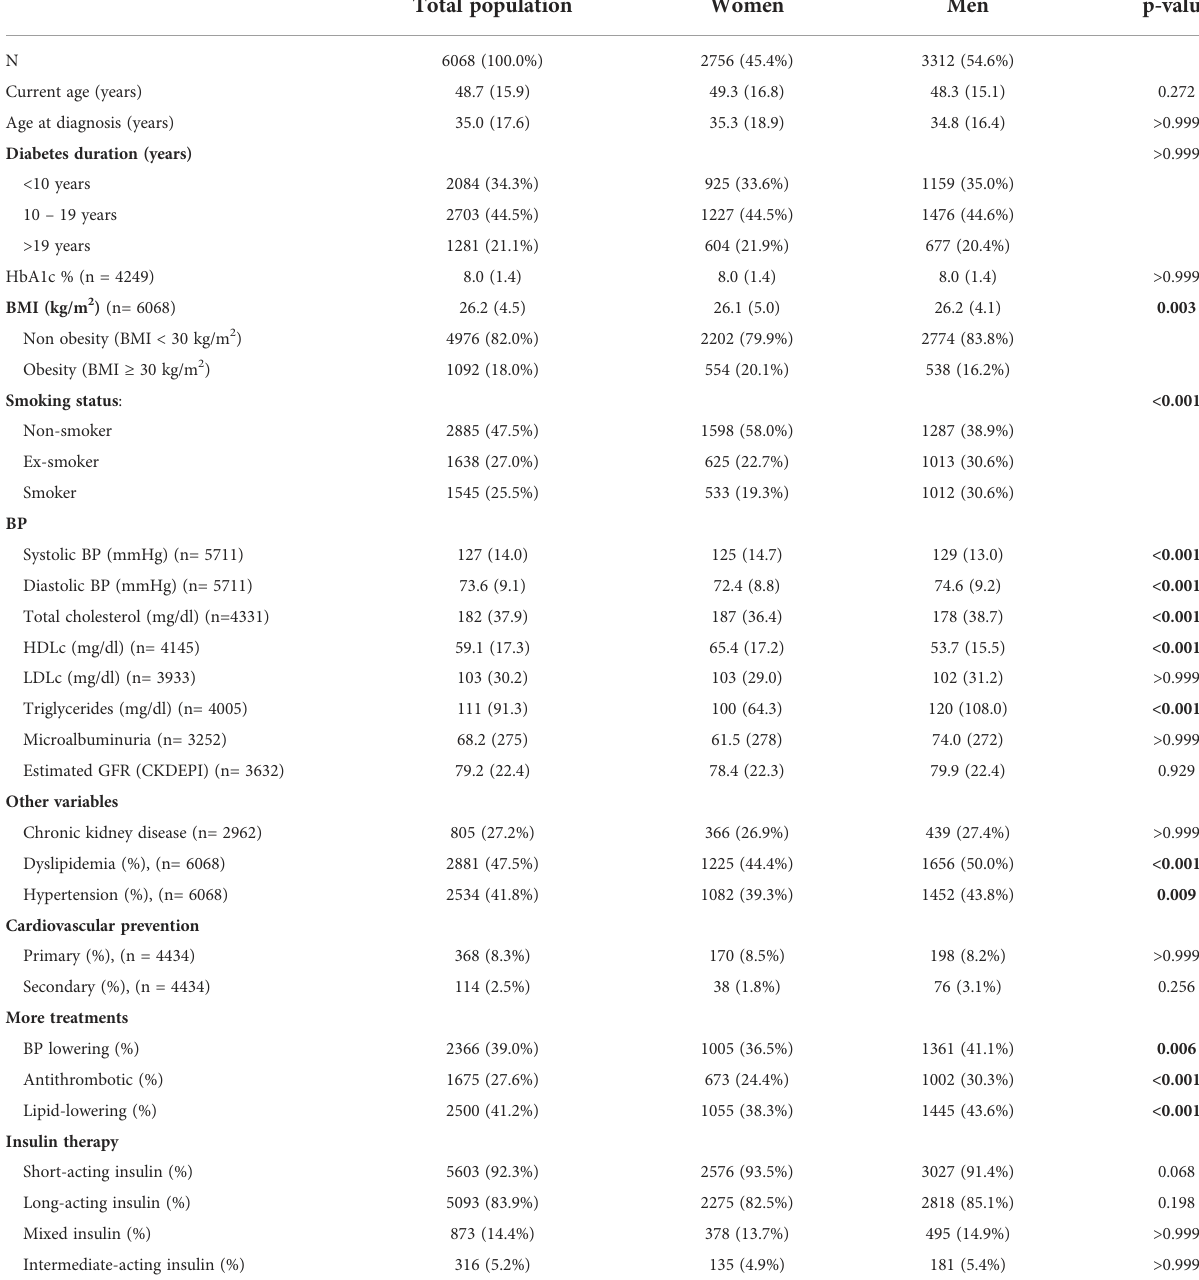
TABLE 1 Characteristics of the whole study population and also according to